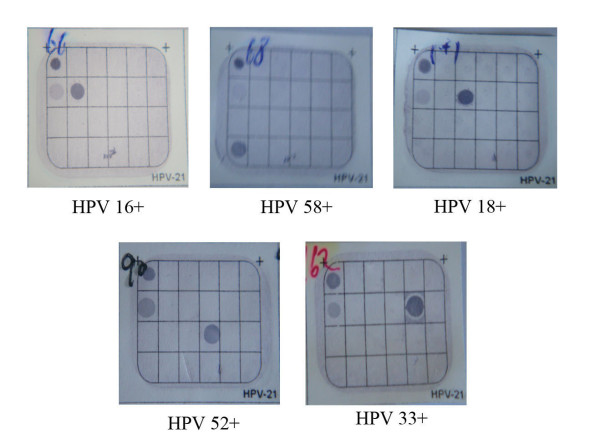
The common high-risk genotypes of persistent positive HPV in the northeast of China. Human papillomavirus genotyping was performed using the HPV GenoArray tests. The common high-risk genotypes of HPV in persistent positivity were HPV-16 (18.21%; 95% CI, 17.04%–19.38%), HPV-58 (13.2%; 95% CI, 12.17%–14.23%), HPV-18 (8.66%; 95% CI, 7.81%–9.51%), HPV-52 (7.06%; 95% CI, 6.28%–7.84%) and HPV-33 (6.78%; 95% CI, 6.02%–7.54%).